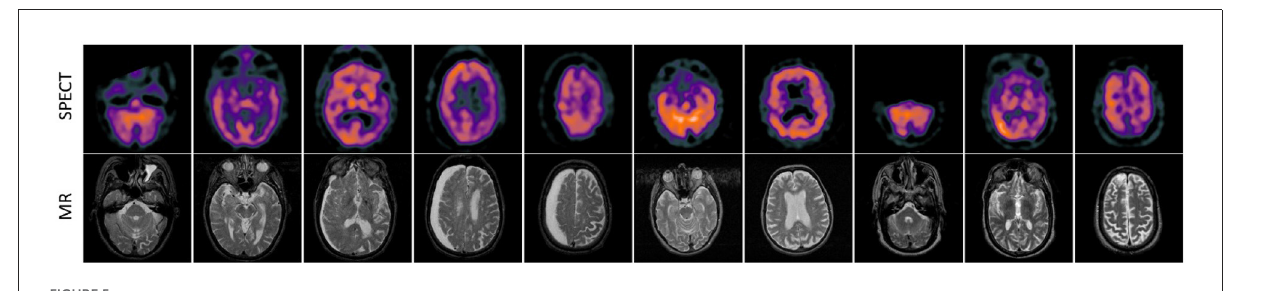
FIGURE5 Ten pairs of images in the SPECT-MR image